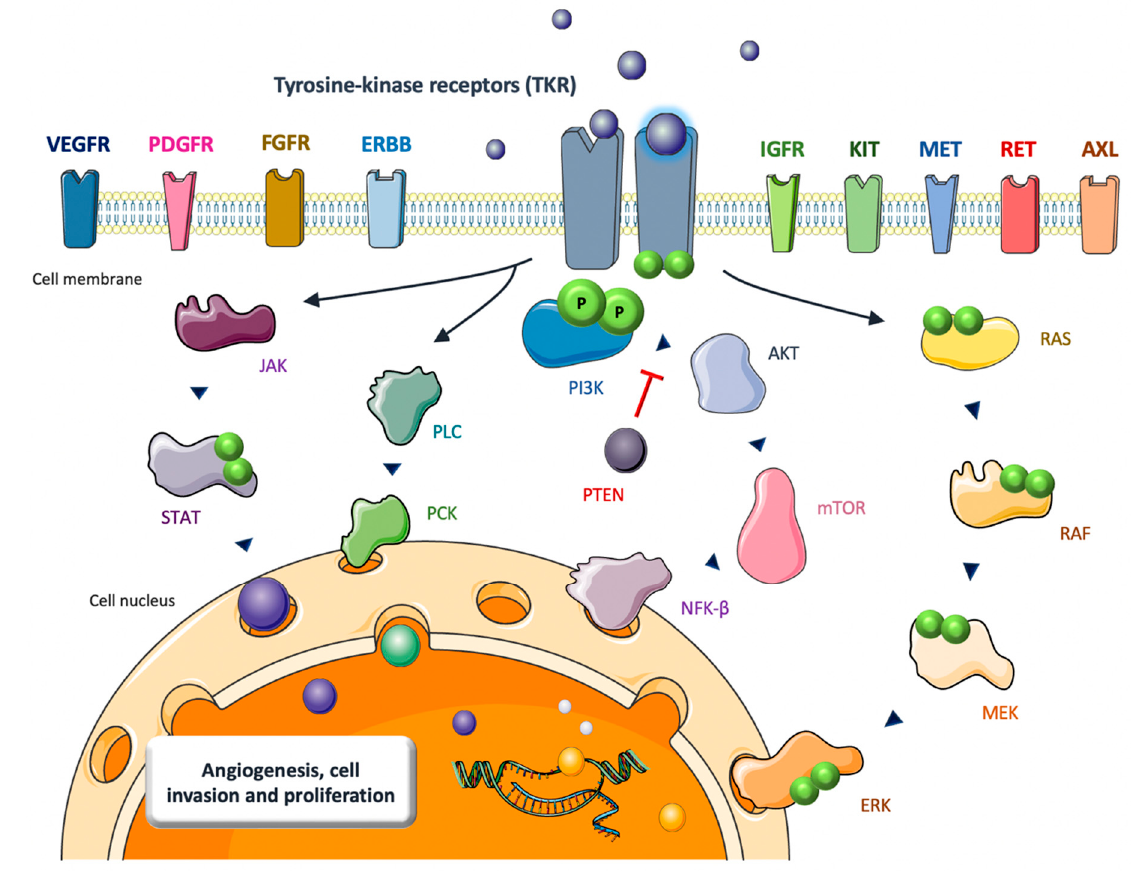
Figure 1. Main downstream oncogenic pathways unleashed by ligand-interaction and dimerization of the transmembrane tyrosine-kinase receptors (TKR) with a potential relevance as therapeutic targets in primary bone tumors: JAK/STAT, PLC/PCK, PI3K/Akt/mTOR, and RAS/RAF/MEK/ERK (MAPK).